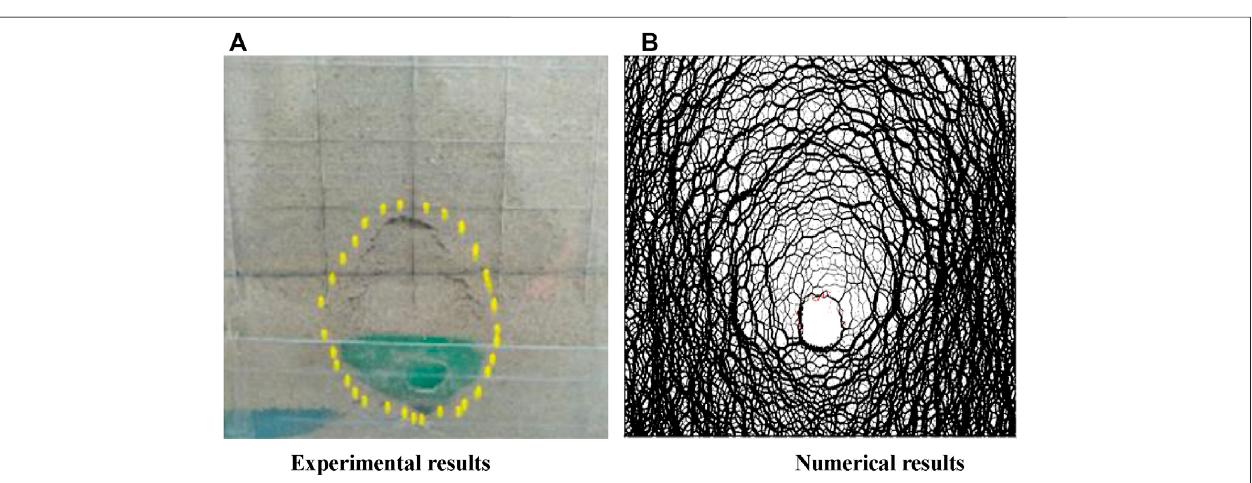
FIGURE 14 | Experimental and numerical results of 25 m deep tunnel after earthquake. (A) Experimental results. (B) Numerical results.